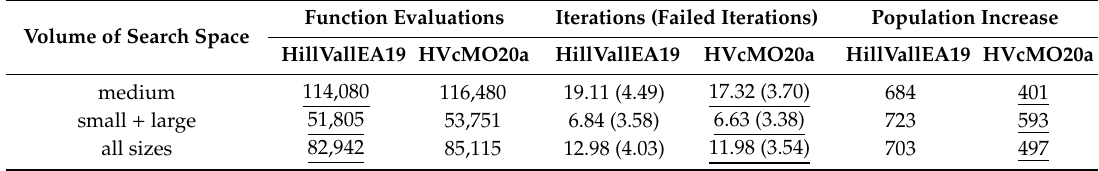
Table 7. Mean values of budget usage, failed iterations and population increase after